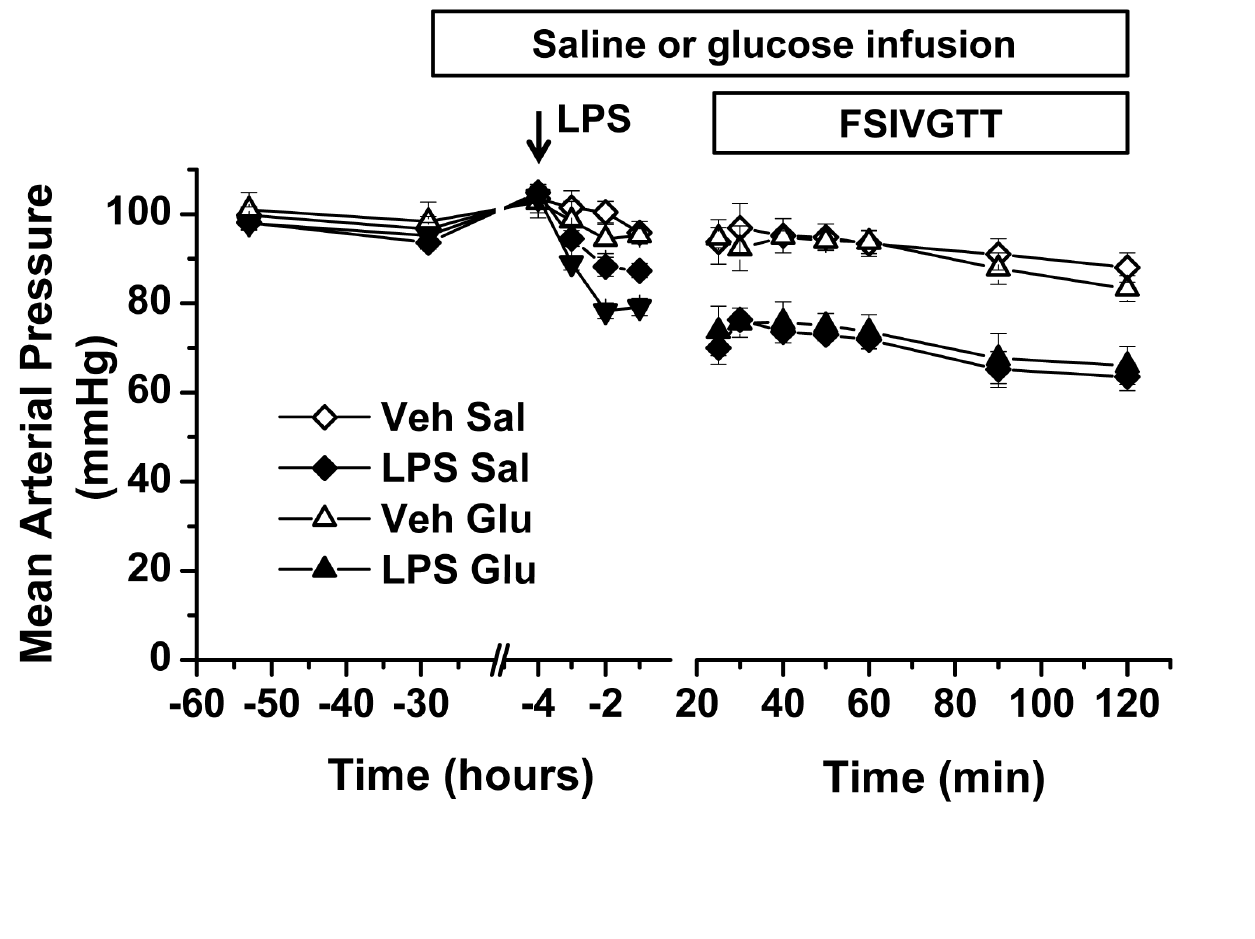
Figure 3. Hemodynamic profiles before and after intra-arterial endotoxin. Change in mean arterial blood pressure over time in four groups of animals receiving either (1) intra-venous saline infusion and vehicle (Veh Sal), (2) intra-venous saline infusion intra- arterial lipopolysaccharide (1 mg/kg, LPS Sal), (3) intra-venous glucose infusion and vehicle (Veh Glu), (4) intra-venous glucose infusion and LPS (1 mg/kg, LPS Glu). Time scale is adjusted to indicate effects of intra-venous saline and glucose infusion, LPS administration, and the frequently sampled intravenous glucose tolerance test